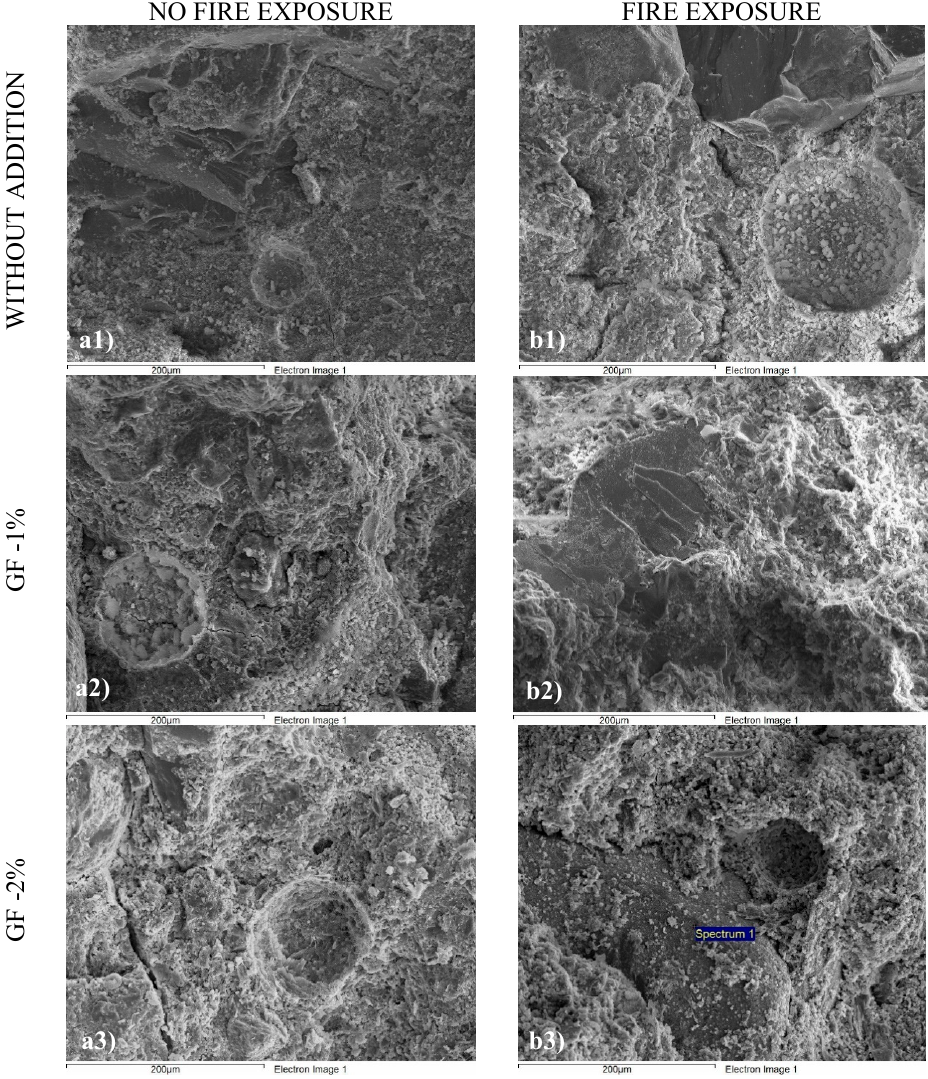
Figure 8. Scanning electron microscopy at 300 magnifications in test pieces without addition SA, and with the addition of CNFs in percentages of 1 and 2% by weight of cement GF-1%, GF-2%. ( a1–a3 ) Before thermal aggression; ( b1–b3 ) After thermal aggression.